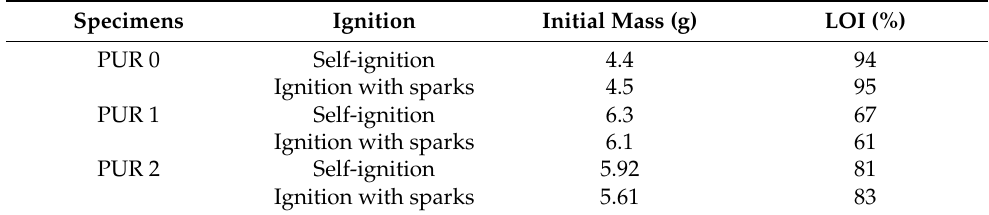
Table 7. Initial mass and loss on ignition for PURs exposed to the 40 kW/m 2 of heat flux; self-ignited and ignited with a spark igniter.